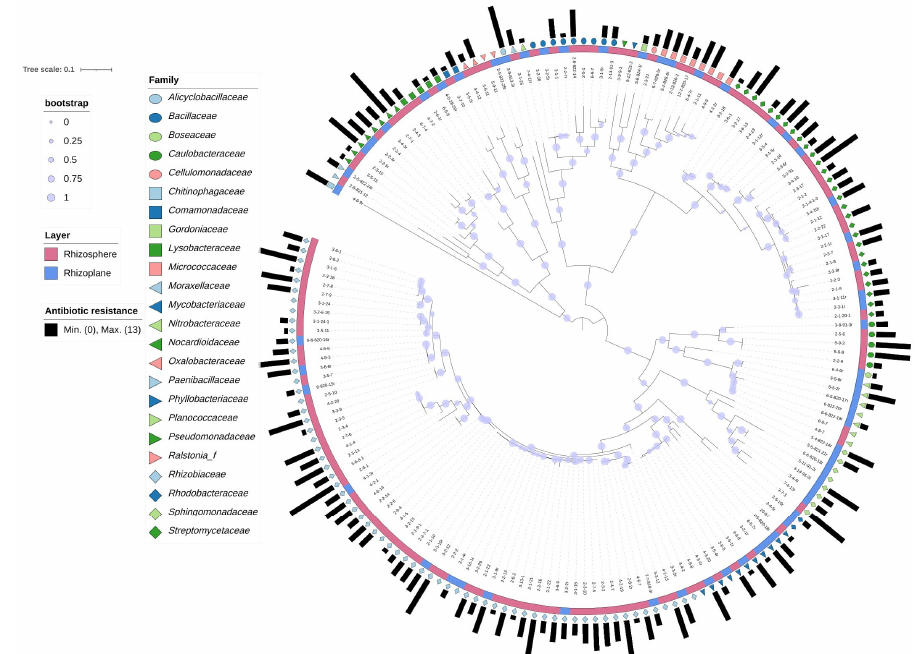
Figure 2. Phylogenetic tree, reconstructed based on the 16S rDNA sequences of the 174 isolates. The taxonomic information of the isolates is shown at the family level. The most inner circle is the isolate names. The second circle shows the origin of the isolates (rhizosphere—pink, rhizoplane—blue). The third circle is the taxonomic affiliation of the isolates. The outermost circle is the accumulated amount of antibiotics each isolate is resistant